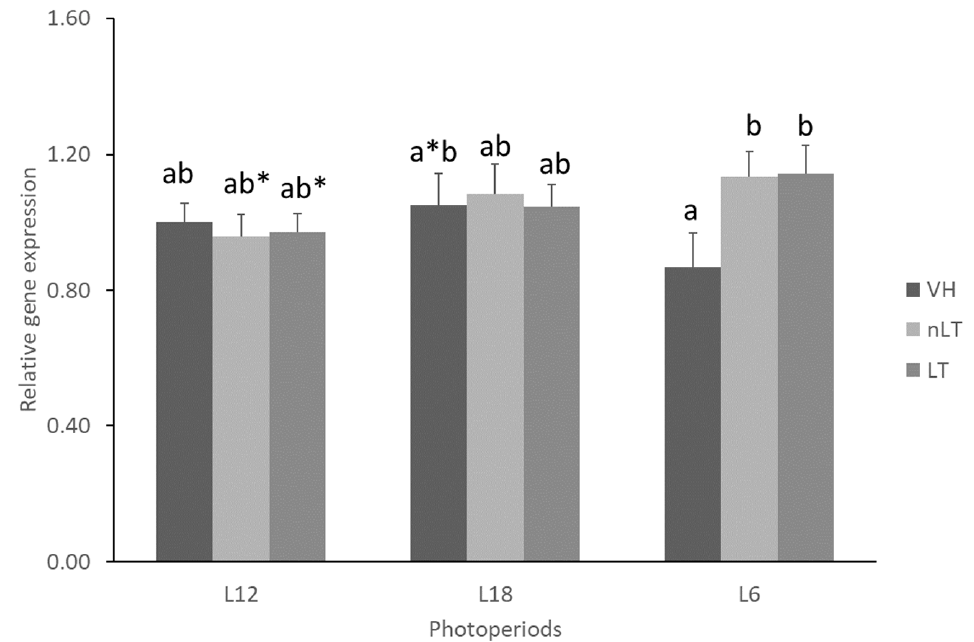
Figure 4. The mRNA levels of fatty acid transporter 5 (Fatp5) of male Fischer 344 rats treated for 7 weeks with vehicle (VH), non-local tomatoes (nLT), or local (LT) and exposed to different photoperiods (short: L6, standard: L12, or long: L18). Values expressed as mean ± SEM ( n = 8). The values were normalized by the L12-VH group. Different letters above the bars indicate significant differences ( p < 0.05) (post hoc DMS, one-way ANOVA). * Indicate trend (0.05 < p < 0.1).